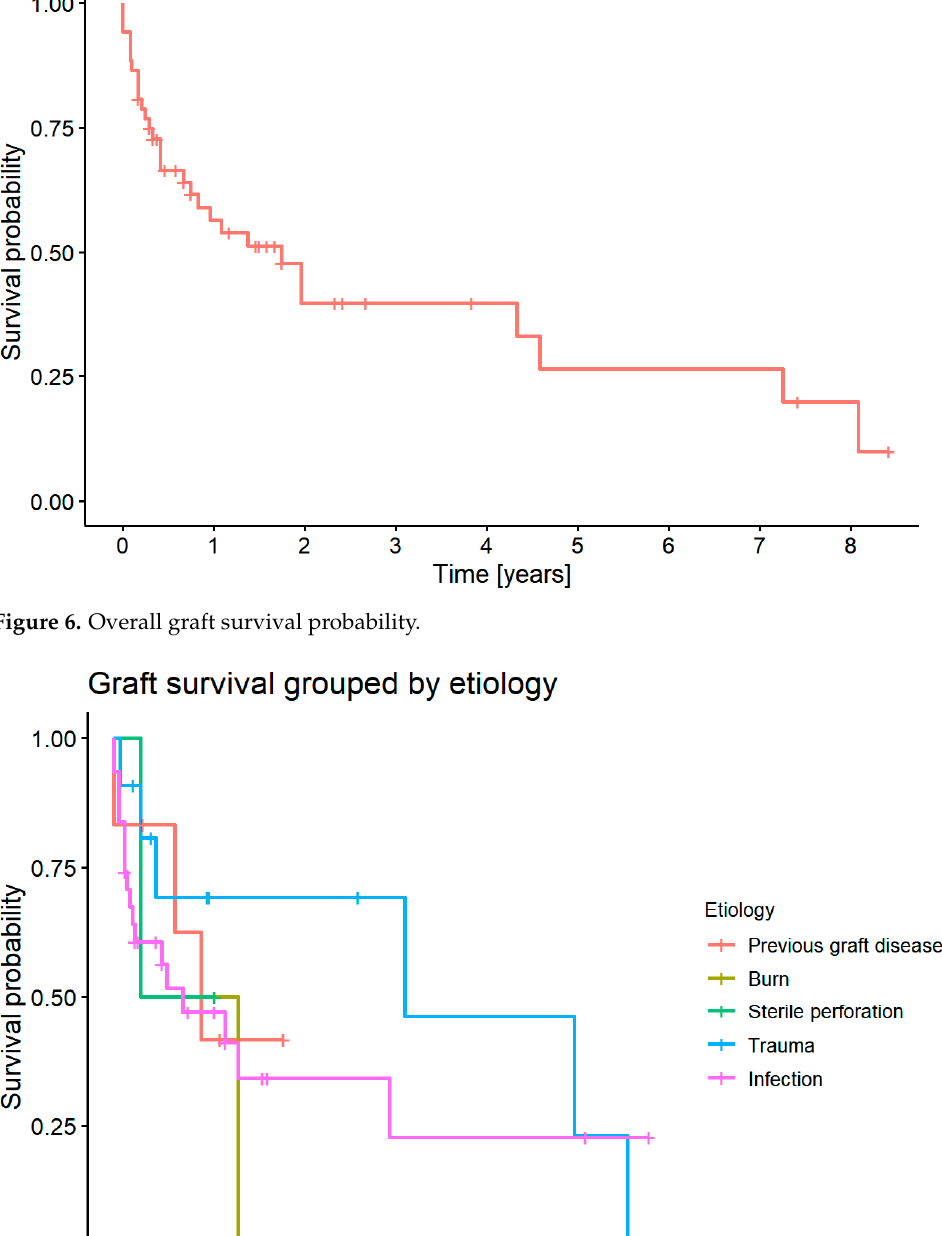
Figure 8. Survival probability for females and males. 3.7.4. Graft Survival Probability: Influence of Previous Surgical Procedures on the Eye A history of previous surgical procedures on the eye did not have an impact on graft survival in our study group ( p = 0.5) (Figure 9).